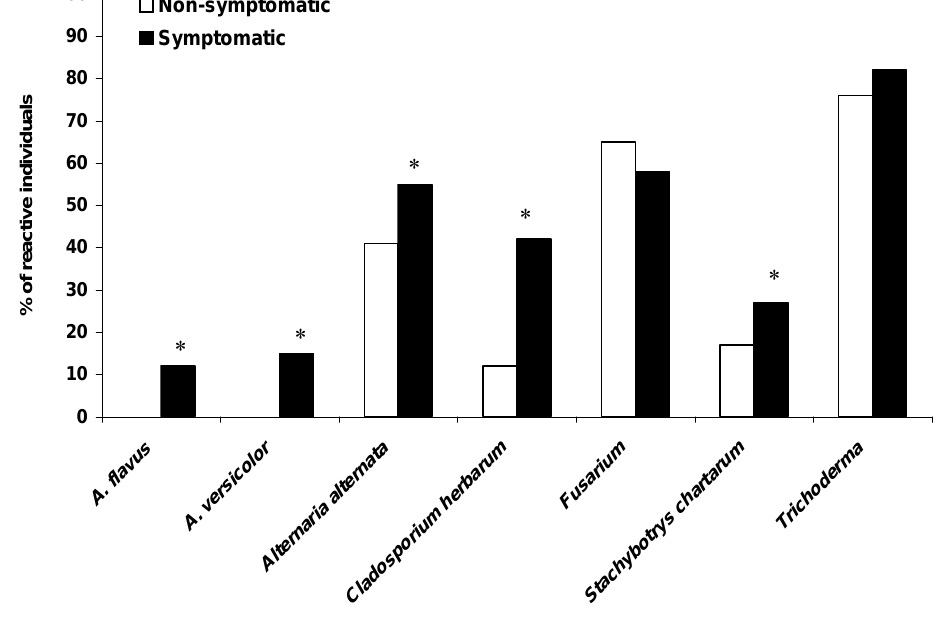
Figure 4. Proliferative responses of PBMC from symptomatic (filled bars) and non- symptomatic (clear bars) populations. Results are given as percent of reactive individuals to diverse mold antigens after in vitro stimulation. Chi-square analysis was performed to assess percent data; asterisks represent “ p ” value <